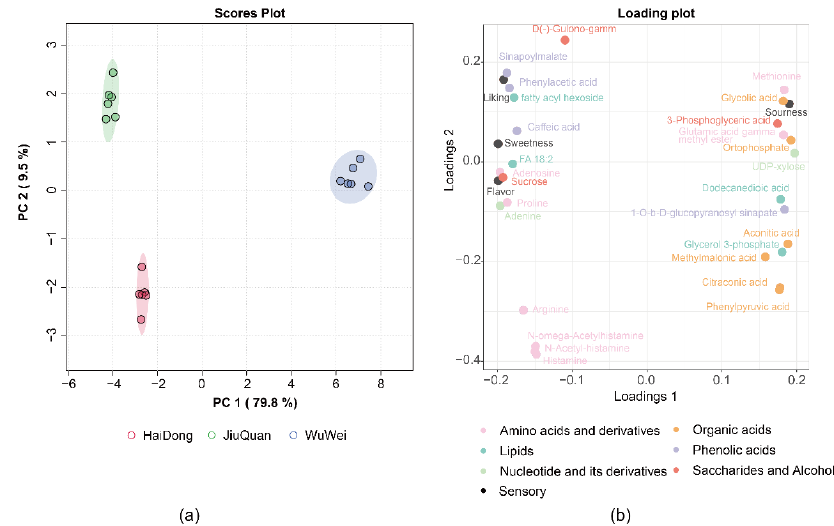
Figure 6. PCA plots of the scores ( a ) and loadings ( b ) of the three regional pepino.